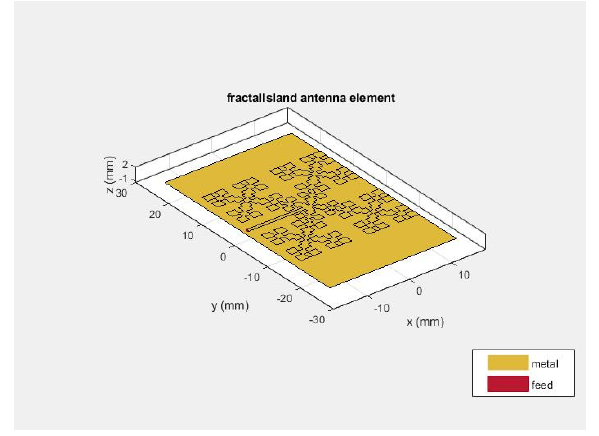
Figure 6. Fractal island antenna element (for fourth iteration).